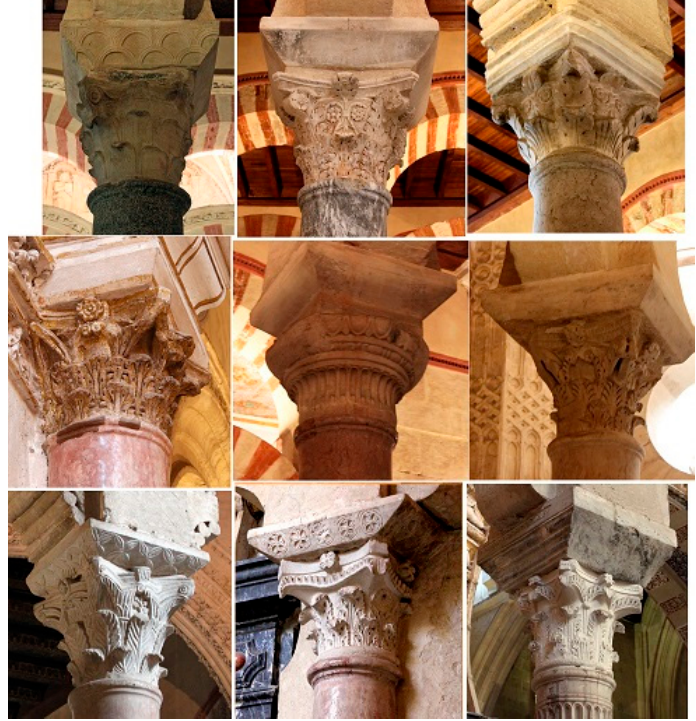
Figure 1. Roman and Visigothic capitals in the 8th and 9th century phases of the Great Mosque of Cordoba. © Photos took by author.